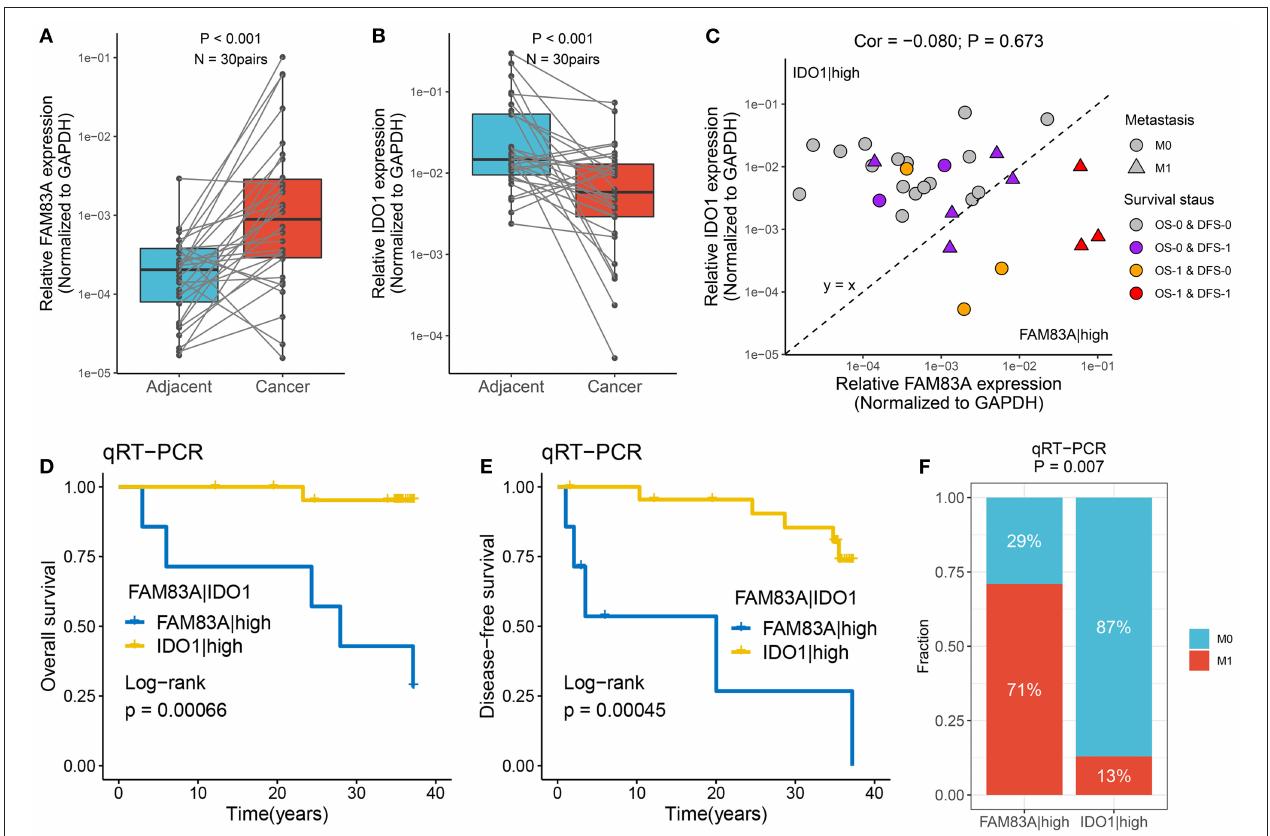
FIGURE 9 | Verified the role of FAM83A|IDO1 in prognosis and metastasis using qRT-PCR. (A,B) The expression difference of FAM83A (A) and IDO1 (B) between two subtypes. (C) The mRNA expression of FAM83A and IDO1 as well as the clinical outcomes in our cohort. The abscissa is the expression of FAM83A , and the ordinate is the expression of IDO1 . Under the line y = x, FAM83A > IDO1 , while above it, FAM83A < IDO1 . M0, no metastasis; M1, metastasis. OS-0, alive; OS-1, death or censoring; DFS-0, disease free; DFS-1, disease or censoring. (D,E) Kaplan–Meier analysis of OS (D) and DFS (E) for FAM83A|IDO1 in our cohort. (F) The relative proportion of patients with distant metastasis between FAM83A |high and IDO1 |high groups in our